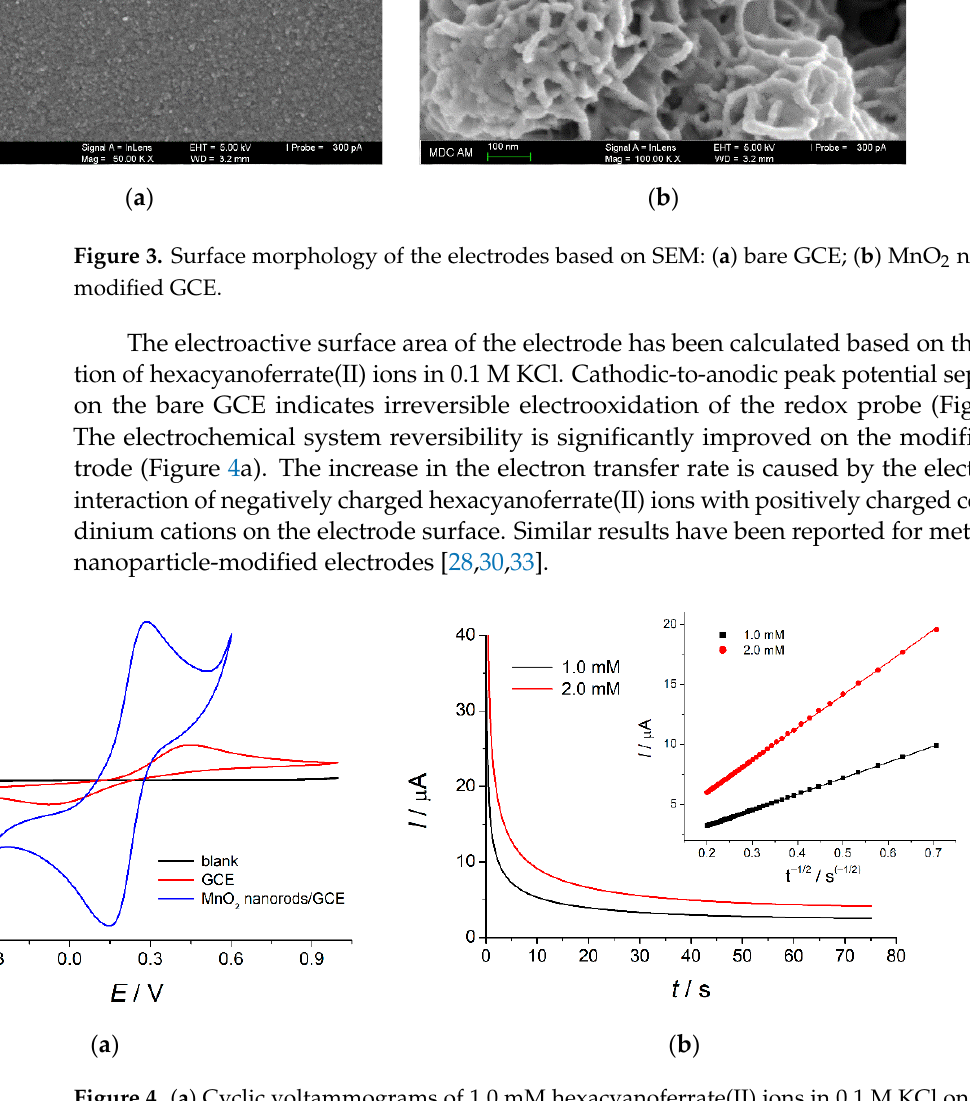
Figure 4. ( a ) Cyclic voltammograms of 1.0 mM hexacyanoferrate(II) ions in 0.1 M KCl on the bare GCE and MnO 2 nanorods-modified GCE( υ = 100 mV s − 1 ); ( b ) Chronoamperometric curves of hexacyanoferrate(II) ions in 0.1 M KCl on the bare GCE at 0.45 V. The inset is the plot of I vs. t − 1/2